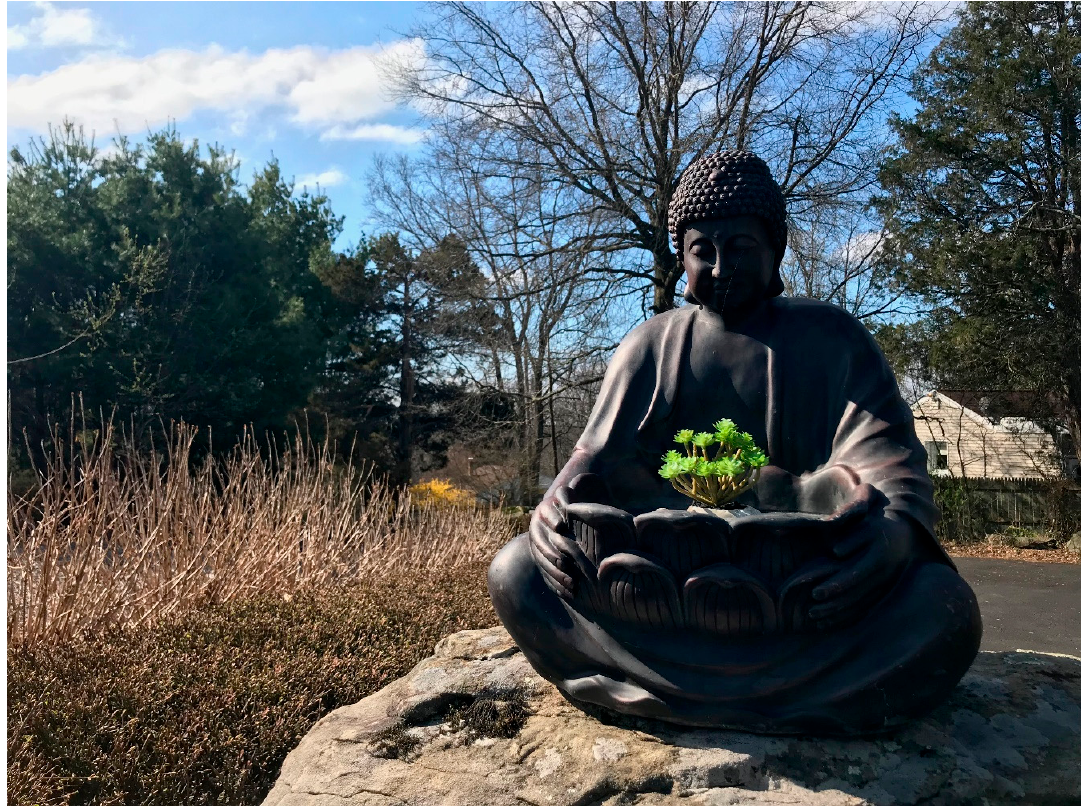
Figure 4. Buddha statue along the walking meditation path at Hwa Um Sa, (Doylestown, PA). Source: www.jivaka.net.